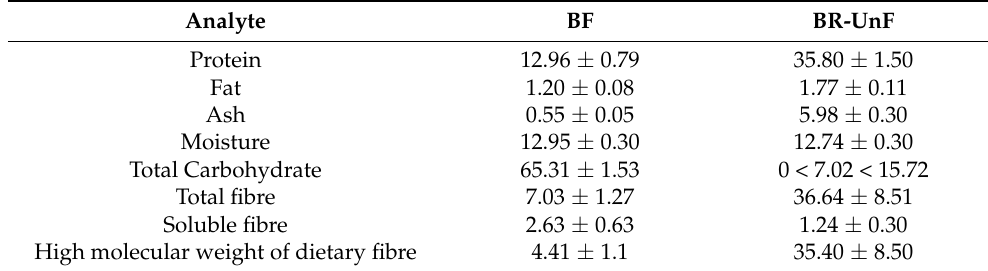
Table 2. Compositional analysis of bakers’ flour (BF) and unfermented barley rootlets (UnF-BR) measured in g/100 g. Results are represented as mean values ± standard